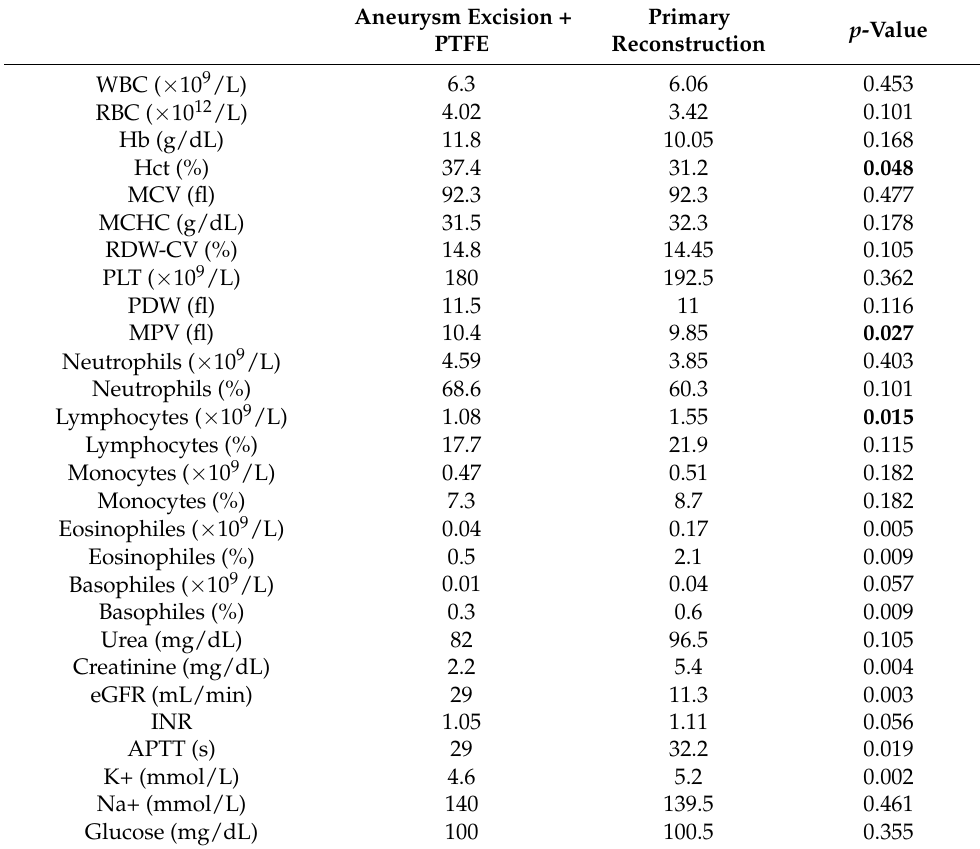
Figure 3. Comparison of primary, primary assisted and secondary patency rates of dialysis fistulas reconstructed by fistula aneurysm combined with primary reconstruction or PTFE graft in kidney transplant patients (KTx). Table 6. Morphology and biochemical parameters in the kidney transplant patients—all-native vessel vs. PTFE bypass